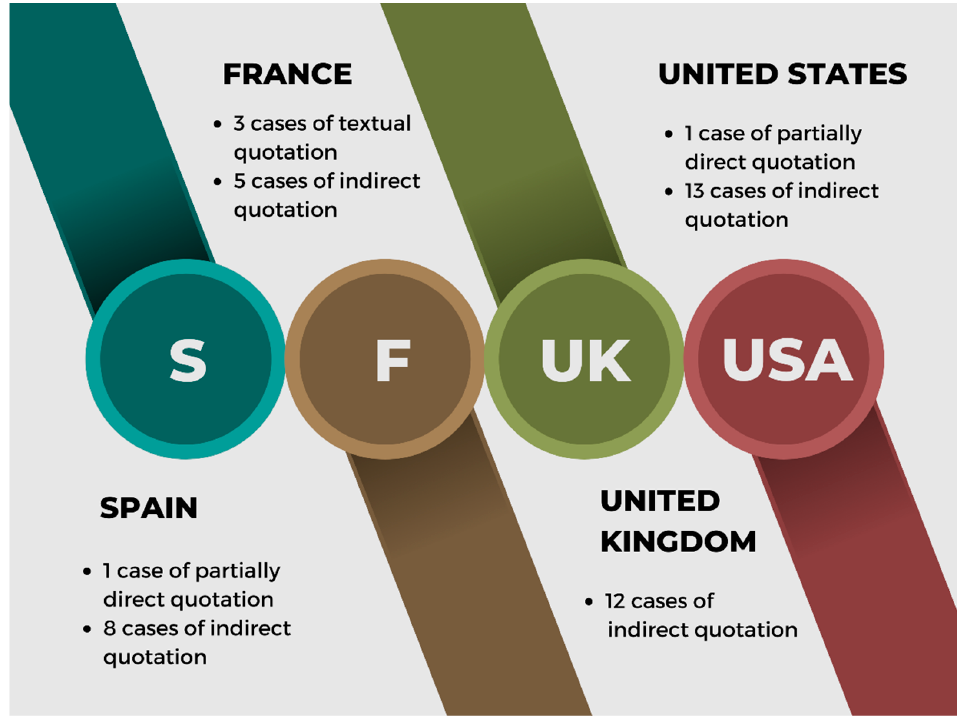
Figure 11. Analysis of quotes in COVID-19 ′ s headlines.